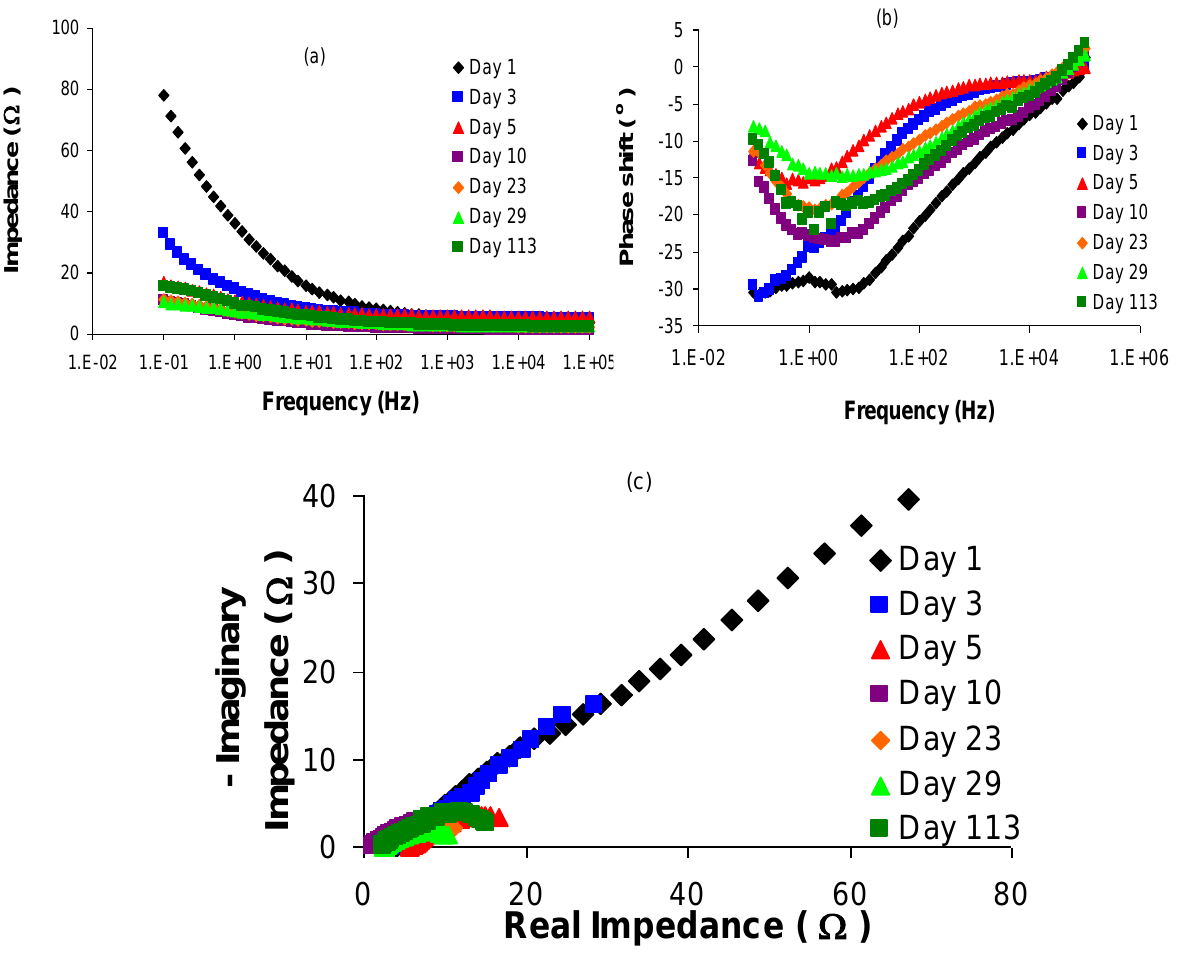
Figure 4. (a) Bode plot showing impedance data for superimposition of EIS scans taken over 113 days. (b) Bode plot showing phase shift data for superimposition of EIS scans taken over 113 days. (c) Nyquist plot showing superimposition of EIS scans taken over 113